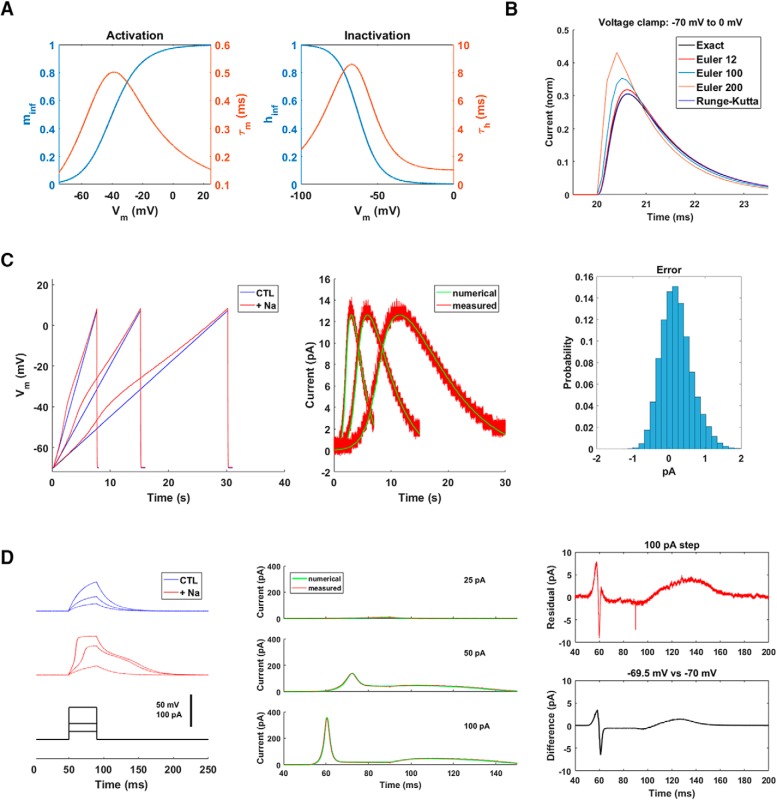
Sodium conductance. A, The conductance was modeled using both an activation gate m(Vm,t) and an inactivation gate h(Vm,t). The steady-state and kinetic values of the two gates are plotted. The total sodium current was given by gNam
3h(Vm – ENa), where gNa is the maximal sodium conductance and ENa is the sodium reversal potential (50 mV). B, Comparison of different numerical integration methods. In a simulation, the voltage was stepped instantaneously from –70 mV to 0 mV at a time t = 20 ms. The resulting (inward) sodium current was calculated using the forward Euler method (time step 200, 100, or 12 μs), the fourth-order Runge–Kutta method (time step 10 μs), or an exact analytical calculation (exact). For the Euler simulation of 12 μs, the time step was also jittered by 2 μs (standard deviation). C, At left, the response of the model cell to slow current ramps (5, 10, and 20 pA/s) is plotted in the absence (CTL) and presence (+ Na) of an added sodium conductance (gNa = 20 nS). In the middle, the close agreement between the sodium currents produced by the dynamic clamp system (measured) and those expected from precise numerical integration of the Hodgkin–Huxley equations (numerical) is demonstrated. At right is a histogram of the error (difference) between the measured and expected currents. D, The model cell was subjected to brief current steps. Without a sodium conductance, the responses showed pure exponential growth, as expected of an RC circuit. With a sodium conductance (gNa = 80 nS), the responses showed nonlinear behavior above a threshold (>25 pA). The sodium currents (measured directly and expected from numerical integration) are plotted in the middle. Not only do the currents agree with each other, but they show a striking threshold behavior. At right (top), the error (difference) between the measured current and the expected current is plotted for the largest current step (100 pA). The shape of the error is consistent with what would be expected from a small offset in the baseline membrane potential. At right (bottom) is the difference between the fourth-order Runge–Kutta (time step 10 μs) estimate of the current for a baseline of –70 mV and the estimate for a baseline of –69.5 mV.